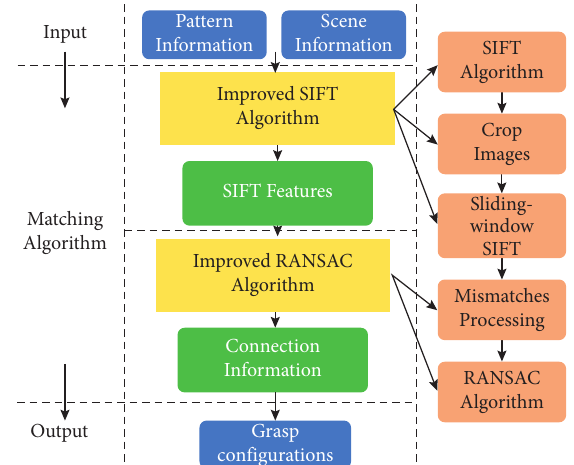
Figure 4: The diagram of our matching algorithm. The matching algorithm combines the improved SIFT algorithm and the im- proved RANSAC algorithm to connect the template information and the scene information. The connection information generated by our matching algorithm contains the transformation relation- ship between the matched pair of images. The output of the matching algorithm includes multiply grasp configurations of the target object in the occluded